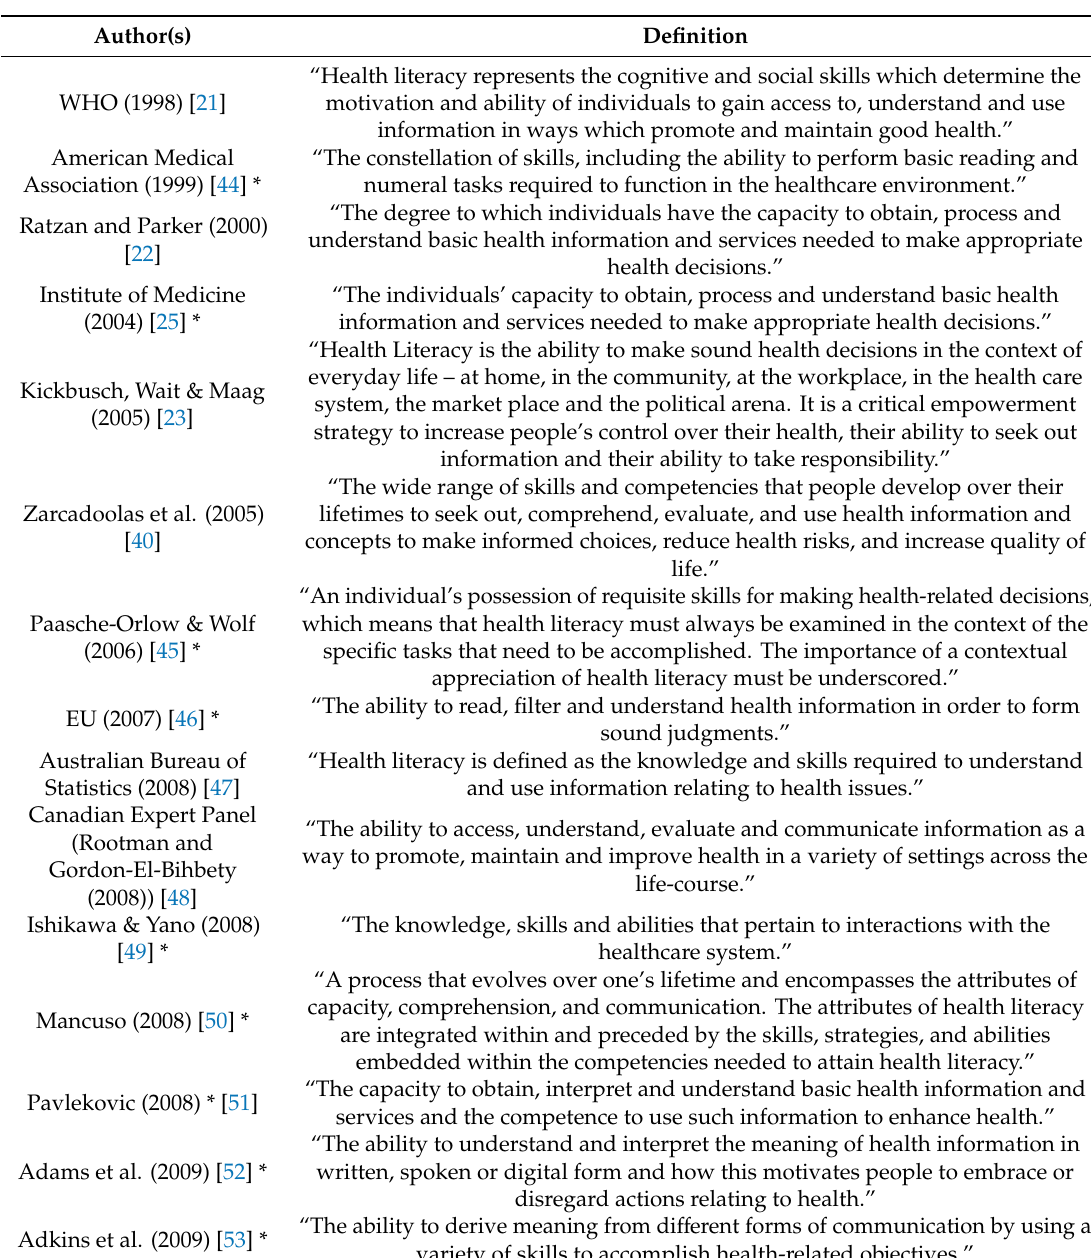
Table A1. Definitions